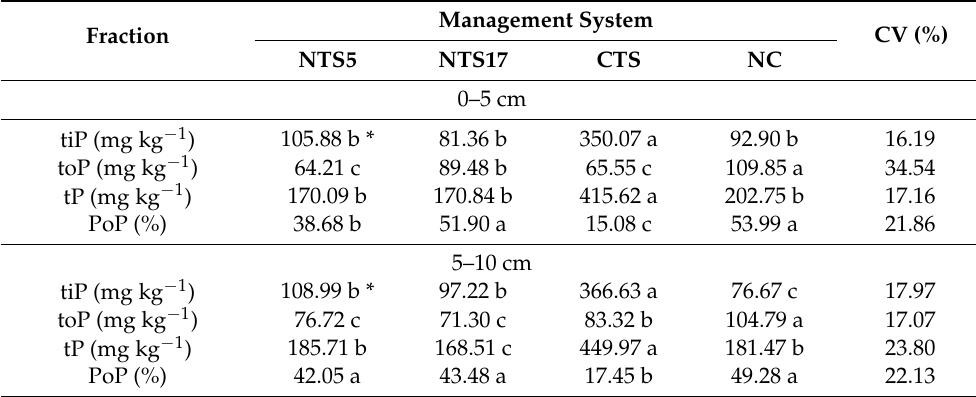
Table 7. Fractions of the forms of P in soil in function of the management system. Management Fraction